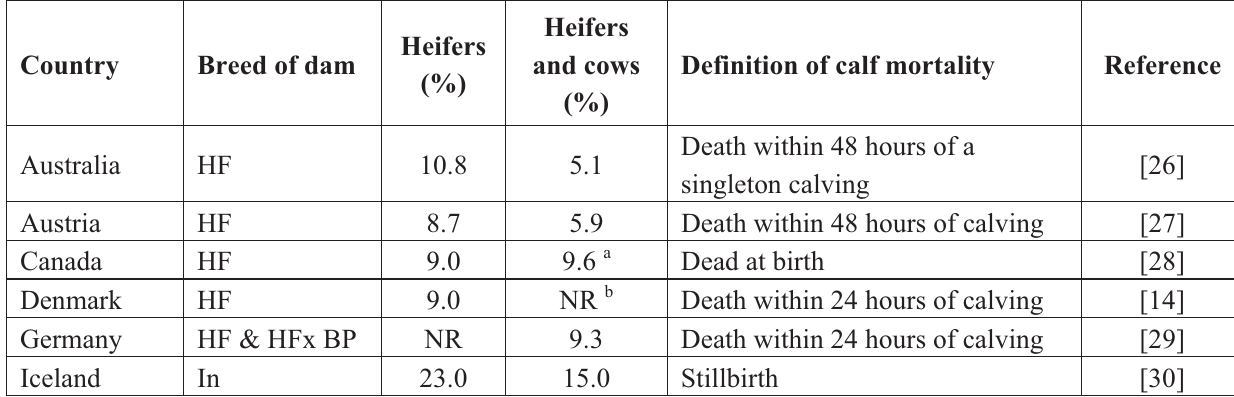
Table 1. Incidence of perinatal calf mortality in dairy heifers and cows in 20 countries internationally